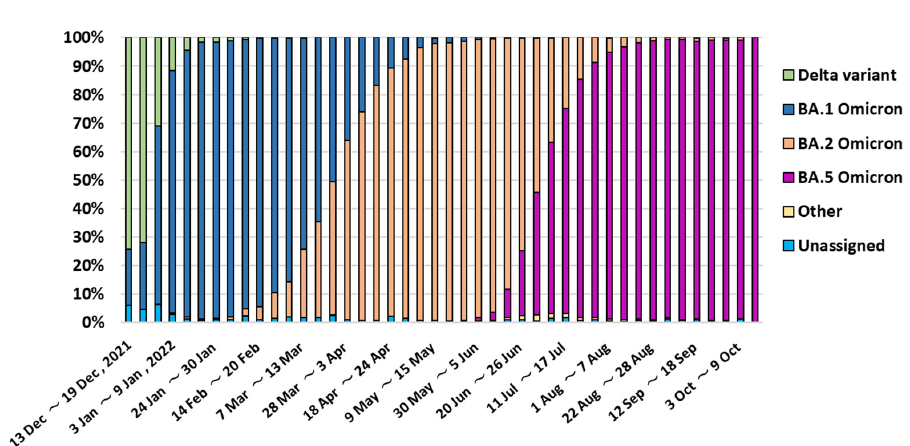
Figure A1. Trends in the changing proportions of the lineage of SARS-CoV-2 in Japan (December 2021~October 2022). These data were obtained from the National Institute of Infectious Diseases [3]. Table A1. Age-standardized fatality rate of COVID-19 cases aged ≥ 40 years caused by the Omicron variant diagnosed between January and August in Japan, 2022.